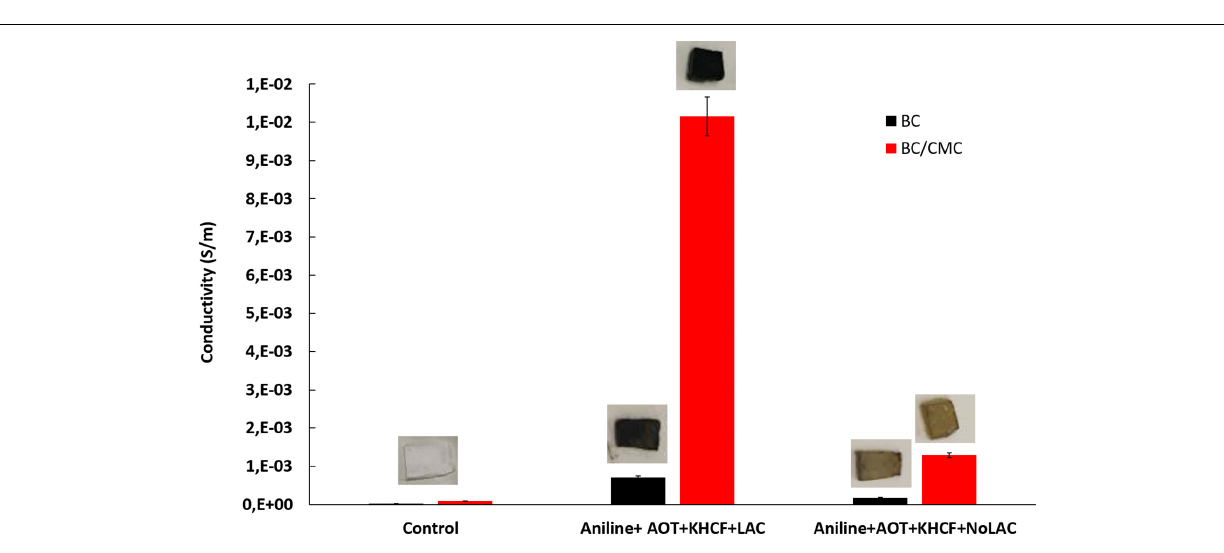
BC (comparing black line with red line), when PANi